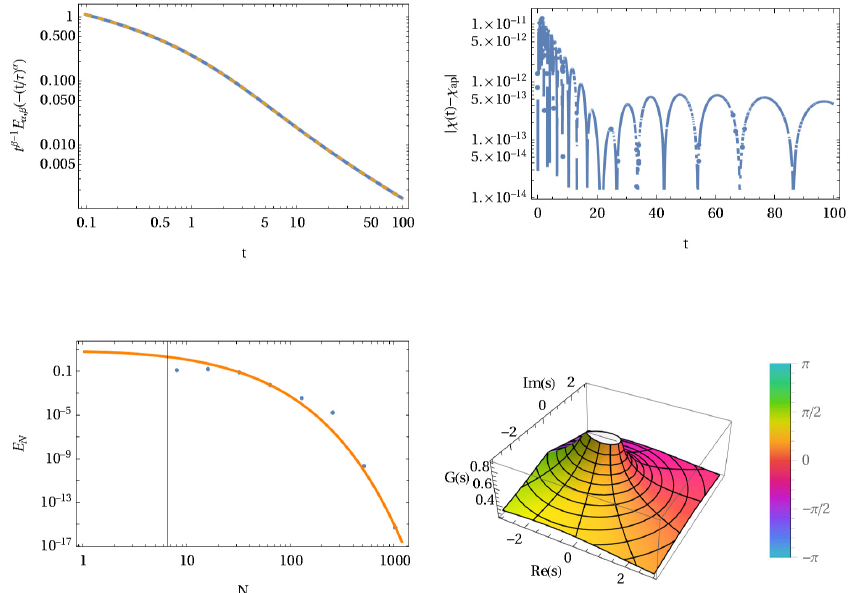
Figure 11. Approximation of the fractional relaxation Equation (92) generated by the SG inverse Laplace transform of G ( s ) . The left panel on top includes the exact solution of the fractional relaxation equation given by χ ( t ) = χ 0 t β − 1 E α , β ( − ( t / τ ) q ) , where E α , β ( t ) is the Mittag-Leffler function. The right panel on top shows the local error between the exact solution and the approximation. The number of approximation points used in the calculation was m = 2 N + 1 = 2049. The parameters to generate the plot are χ 0 = 1, τ = 1, α = 2/3, and β = 3/4. The bottom panels (left) show the √ (cid:16) (cid:17) 1/2 − k N exp error decay as a function of Sinc points N , E N ∼ . Dots represents numerically 1 N determined L 2 norms, and the solid line represents Equation (57) with c = 1/150, where K 1 and k 1 are adapted accordingly. The right panel shows the pole structure with a branch cut along the negative real axis of the transfer function G ( s ) on the complex plane C